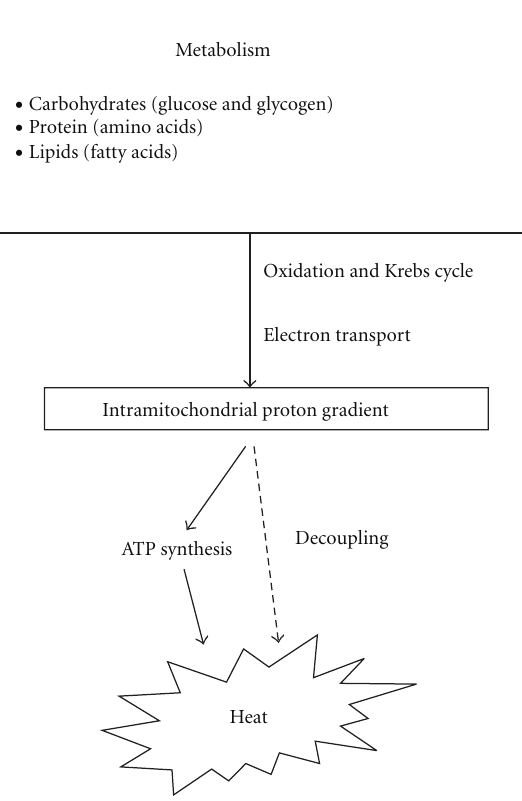
Figure 1: Heat production during energy metabolism. This schema is valid whatever the cell